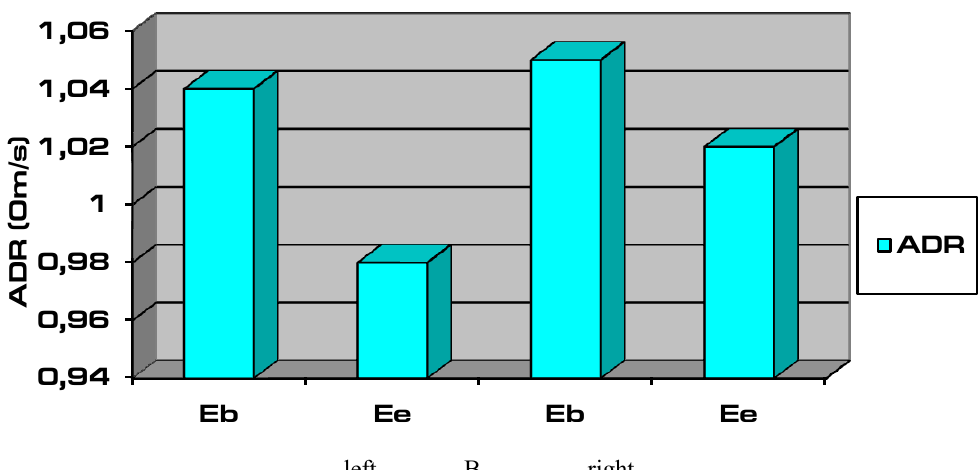
Figure 5. Indexes of peripheral vascular resistance in area of shallow arteries of cerebrum at sportsmen’s (Greek- Roman fight) before and after paravertebral miorelaxation (A - amplitude (absolute) indexes, B - amplitude (relative)): AI - amplitude of low wave; DI – dikrotic index; Eb - beginning of experiment; Ee - end of experiment.